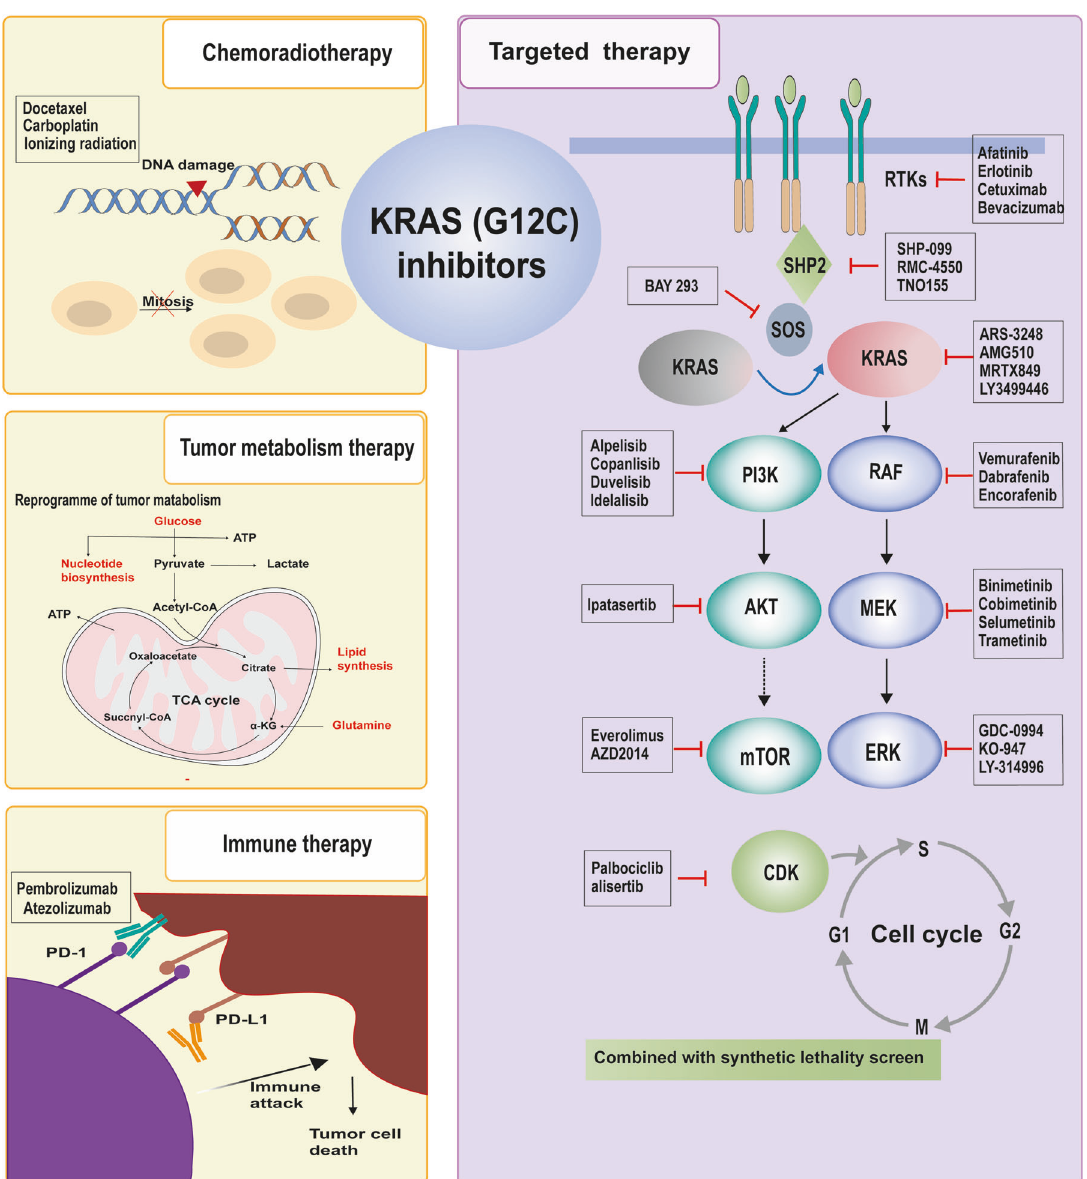
Fig. 6 Combinational strategies for KRAS (G12C) inhibitors. The combined strategy of KRAS (G12C) inhibitors is mainly divided into four parts: combined with chemoradiotherapy, targeted therapy, immune therapy, and metabolic